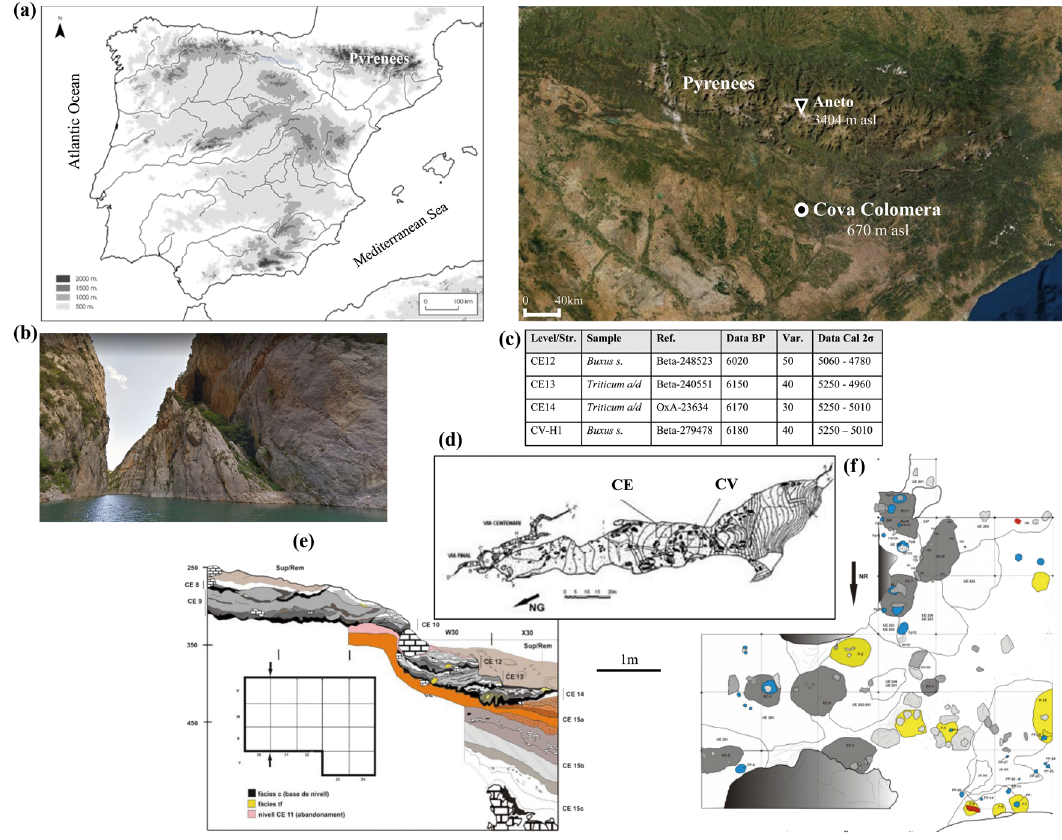
Figure 1: ( a ) Location of the Cova Colomera, ( b ) view of the cave from the river, ( c ) radiocarbon dates of Early Neolithic levels and stratigraphic units, ( d ) plan of the interior of the cave with the location of the two test pits, ( e ) stratigraphic section of sector CE, and ( f ) stratigraphic section of sector